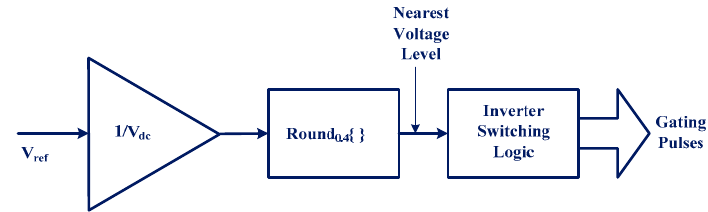
Figure 6. Block diagram of optimized NLC.